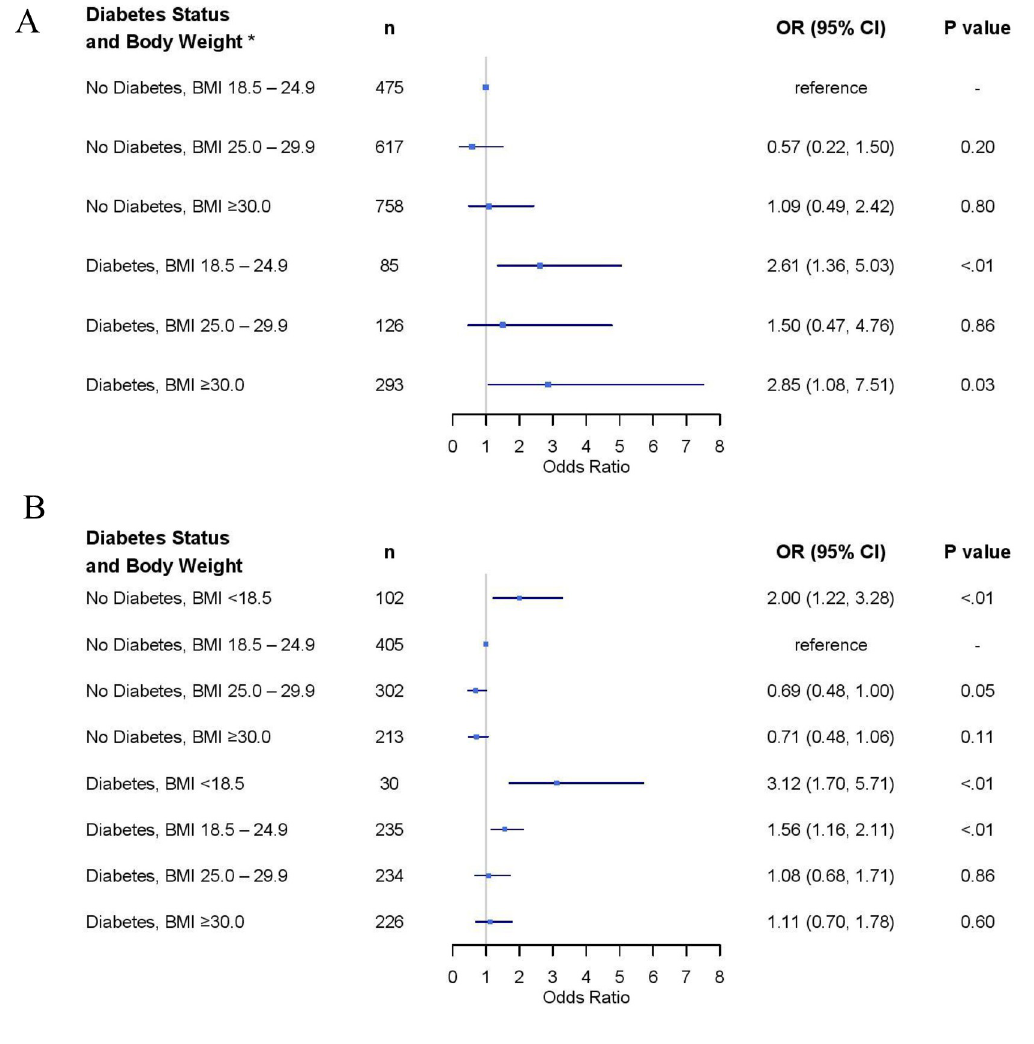
Fig 2. Forest plot of adjusted risk factors for COVID-19 mortality among patients (A) < 65yo and (B) � 65yo.